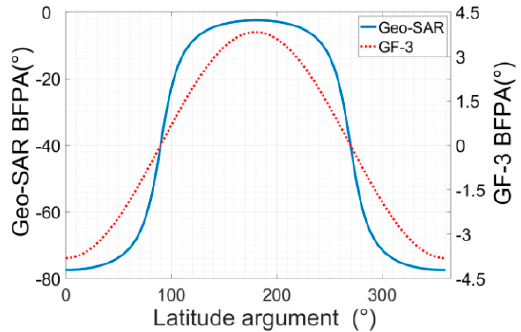
Figure 12. BFPA comparison between GF-3 and Geo-SAR. The largest BPFA of GF-3 is about 3.9 degrees, and that of Geo-SAR is about − 75